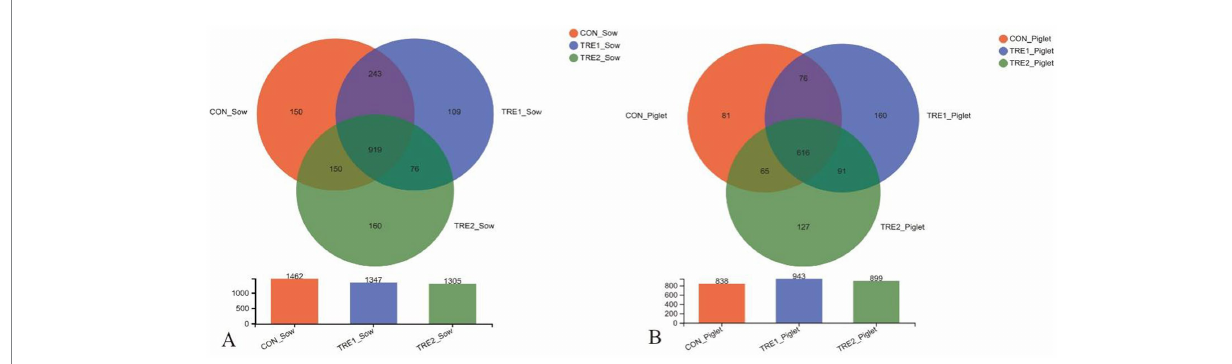
FIGURE 1 The Venn diagram for OTUs of the fecal microbiota of sows and offspring piglets in the control group, TRE1 group, and TRE2